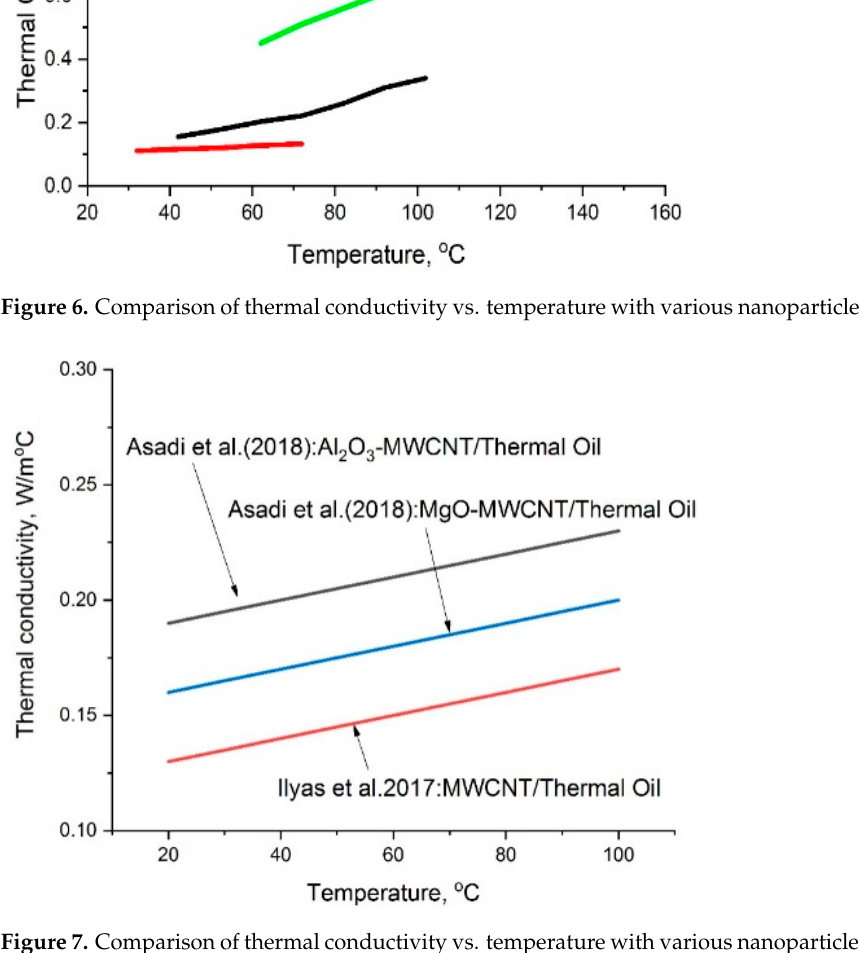
Figure 7. Comparison of thermal conductivity vs. temperature with various nanoparticle/thermal oil.